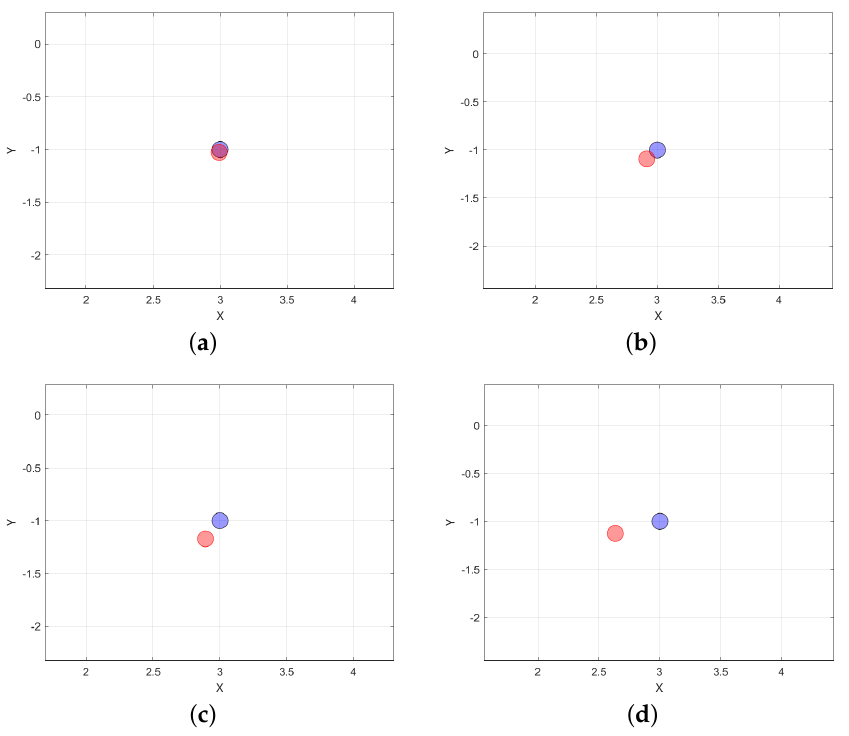
(cid:104) (cid:105) (cid:104) (cid:105) (cid:104) (cid:105) (cid:2) (cid:3) 0, 9 π , 0, 7 π , 0, π and 0, 3 π . They 5 5 2 5